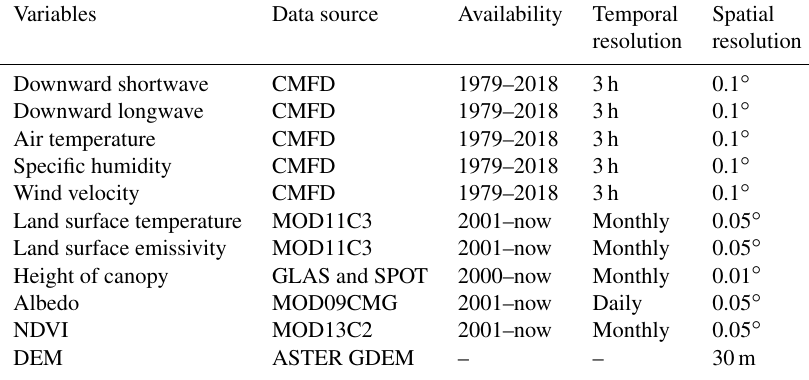
Table 1. Input datasets used in this study. Note that DEM stands for digital elevation model, MOD11C3 is the short name of the MODIS/Terra land surface temperature and emissivity monthly L3 global products, MOD09CMG is the short name of the MODIS/Terra surface reflectance daily L3 global products, MOD13C2 is the short name of the MODIS/Terra vegetation indices’ monthly L3 global products, ASTER GDEM stands for the Advanced Spaceborne Thermal Emission and Reflection Radiometer (ASTER) global DEM (GDEM), GLAS stands for the Geoscience Laser Altimeter System, and SPOT stands for the Systeme pour l’Observation de la Terre